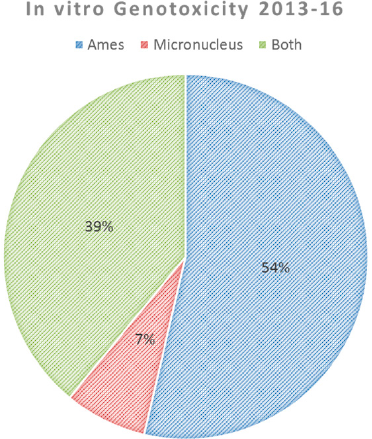
Figure 6. Percentage of the different in vitro studies of genotoxicity of cosmetic ingredients performed in the period